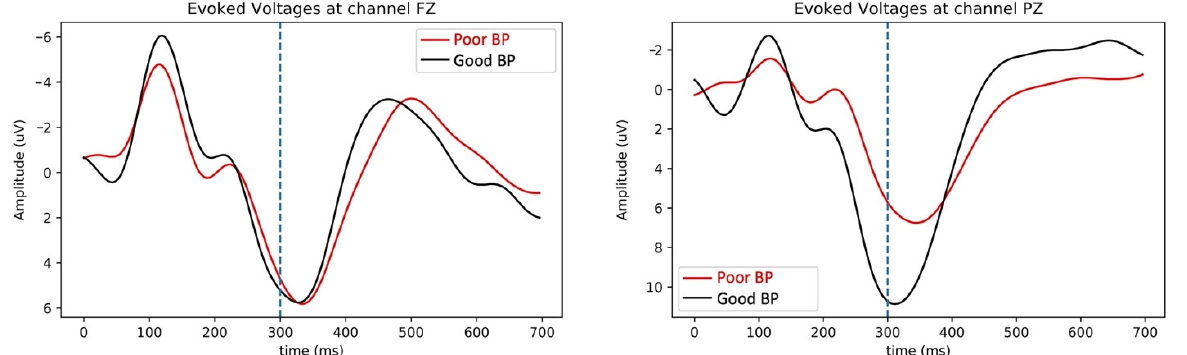
Figure 2. Evoked responses for patients with Good and Poor blood pressure (stressed) as a function of post-stimulus time for two scalp locations (frontal Fz scalp location and parietal Pz location). Black curves represent voltages averaged for all patients with good levels and the red curve is the average for all patients with poor levels. Here, it can be seen that the patients with poor blood pressure had on average a smaller and slower parietal P300 response than those with good levels. Again, we do not see this effect in the frontal locations.